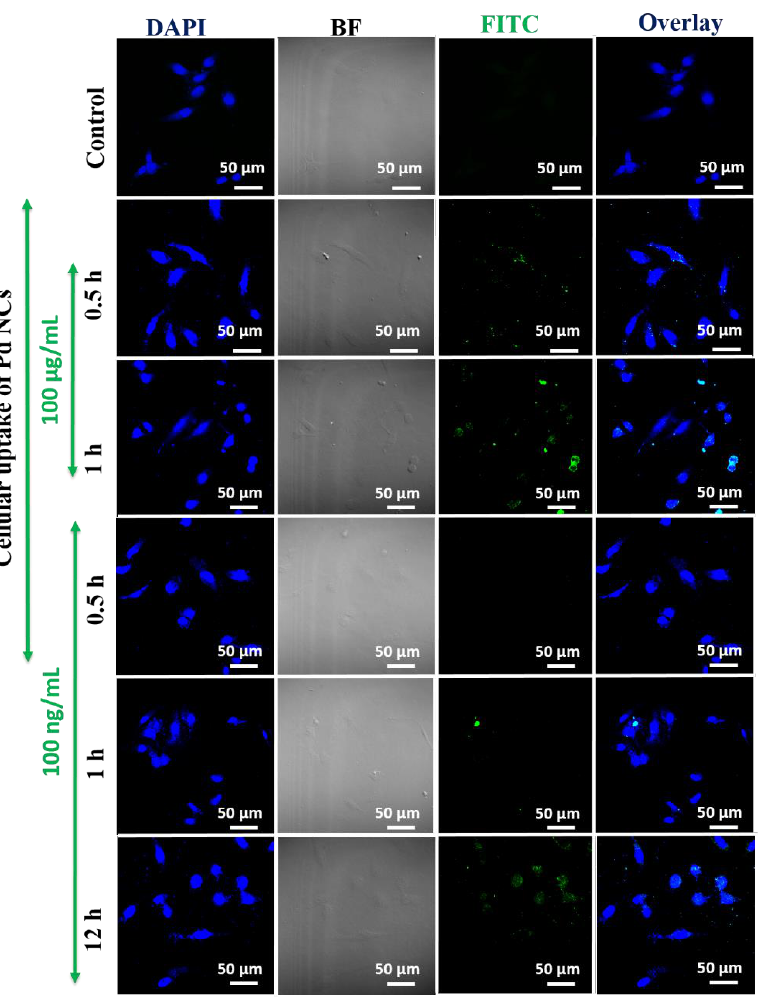
Figure 7. In vitro cell labeling properties of Pd NCs at shorter incubation times (0.5 and 1 h, 100 µg·mL −1 ) and lower doses (100 ng·mL −1 , 0.5, 1 and 12 h).